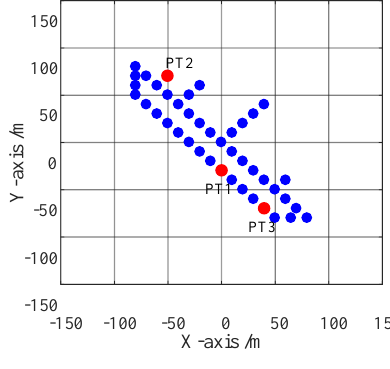
Figure 5. Ship target model.